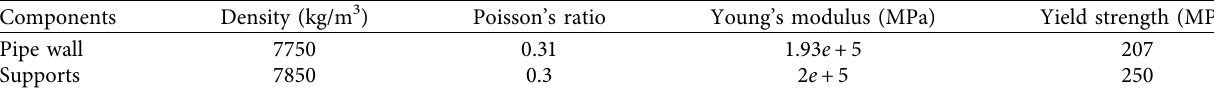
Figure 3: Dimensional diagram of the pipeline structure. Table 1: Material parameters of the pipeline